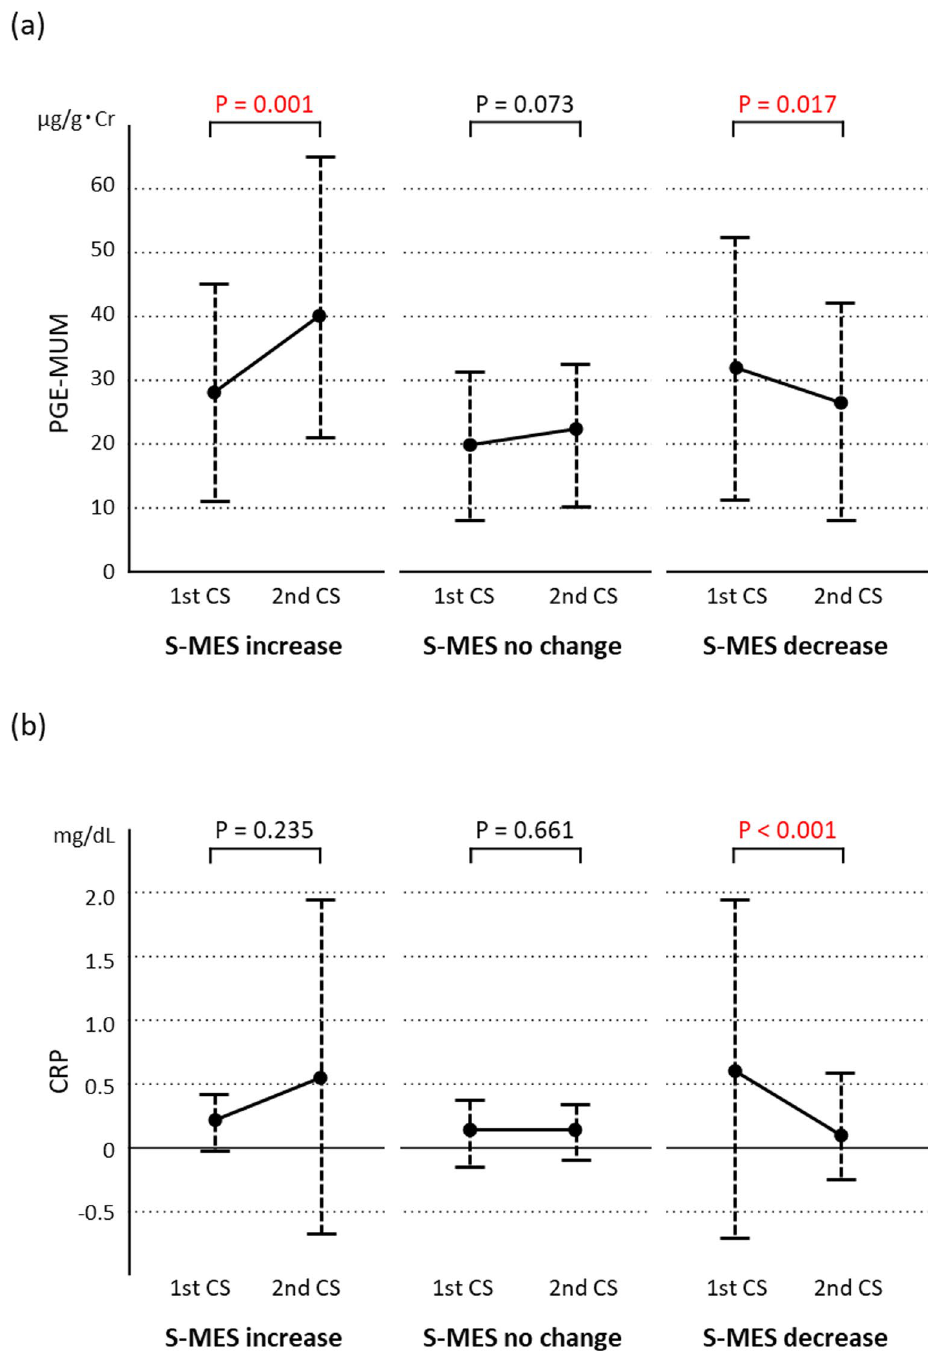
Figure 3. Varying levels of prostaglandin E-major urinary metabolite (PGE-MUM) ( a ) and C-reactive protein (CRP) ( b ) in the Cohort 3 subgroups of sum of Mayo endoscopic subscore (S-MES) increase, no change, and decrease from the precedent colonoscopy (first CS) to the subsequent (second